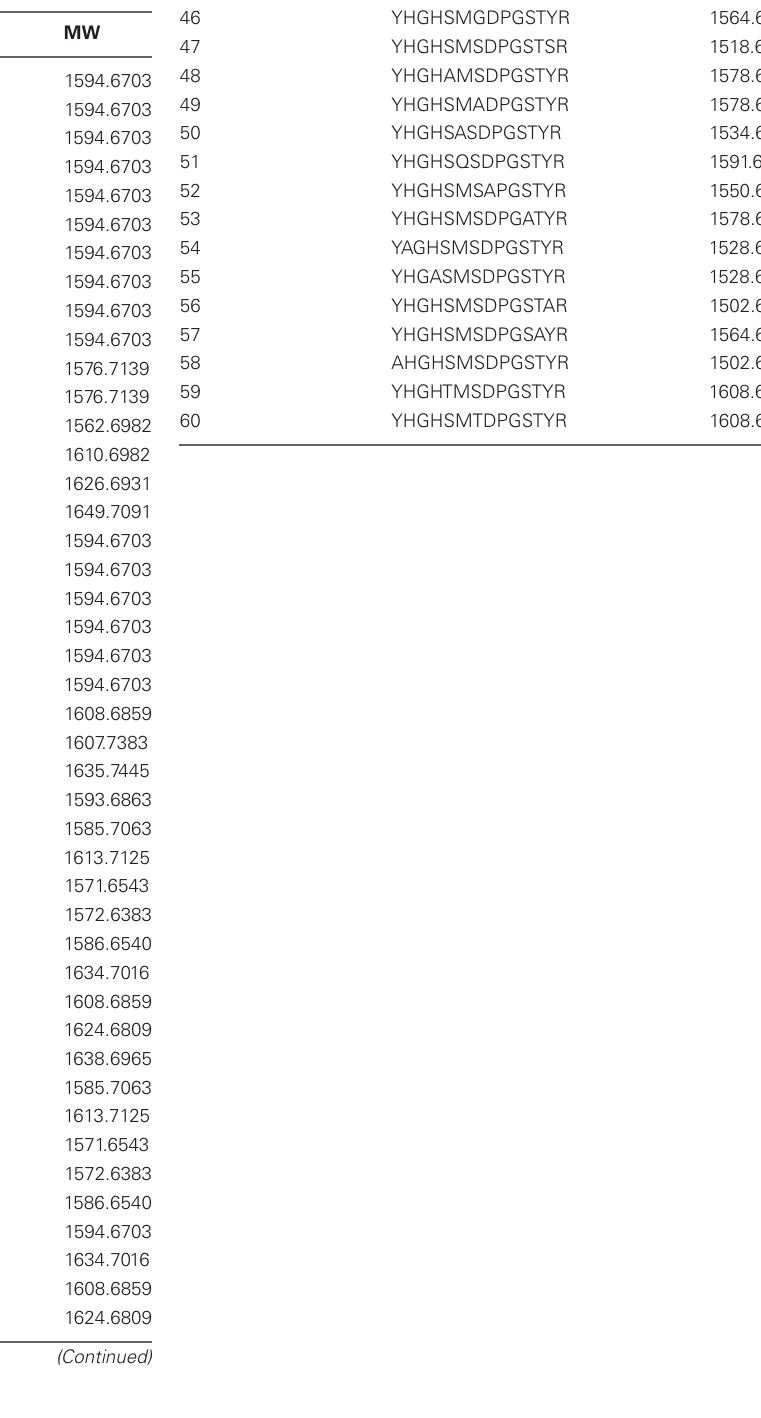
Table A1 | Synthetic peptide-variants of the plant pyruvate dehydrogenase E1 α phosphorylation site 1-flanking